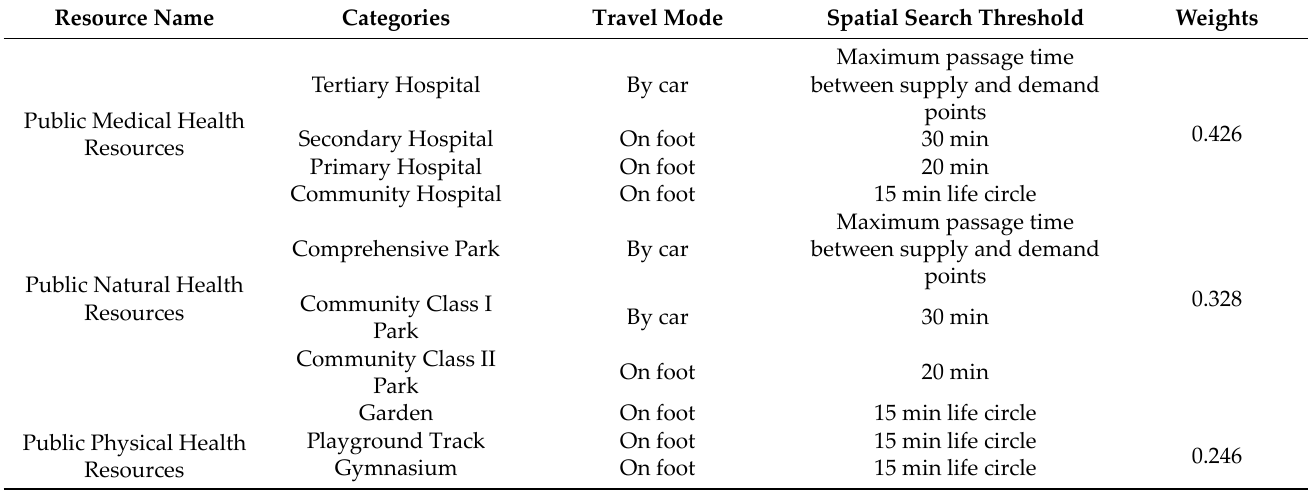
Table 3. Travel mode, spatial search threshold, and weight of urban public health